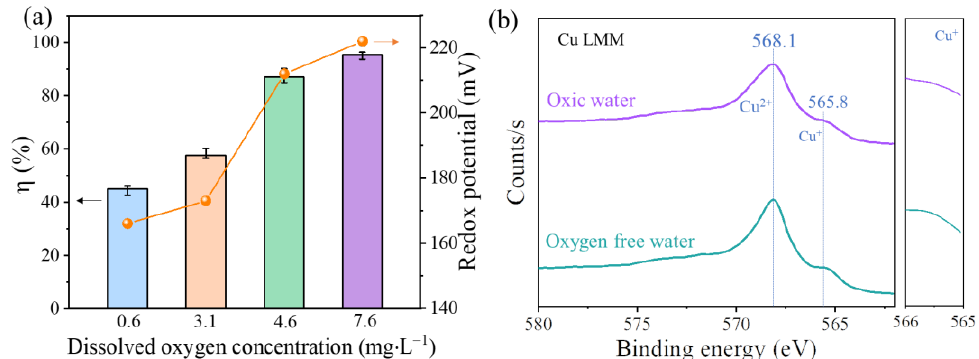
Figure 6. ( a ) The relationship of redox potential and Hg 0 removal efficiency at varied dissolved O 2 concentrations (Experimental condition: solution volume = 10 mL, solution pH = 3.0, solution temperature = 20 ◦ C, flue gas was 0 ~ 9% vol O 2 + N 2 , the inlet concentration of Hg 0 was 200 µ g · m − 3 ). ( b ) XPS spectra of Cu LMM for c-CuS in oxygen-free water and oxic water. The Hg 0 adsorption capacity and rate of c-CuS were investigated and calculated by